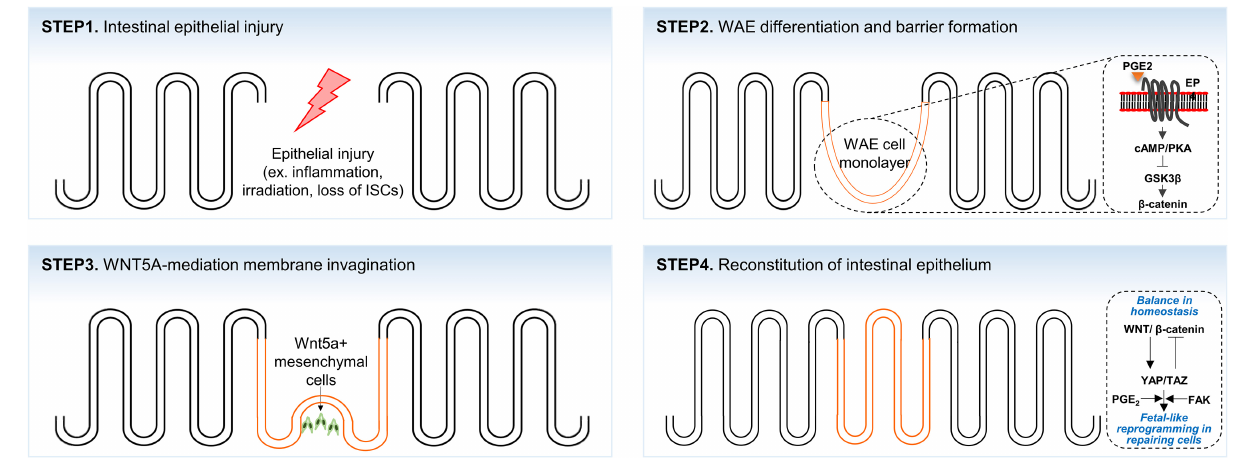
FIGURE 2 | A scheme of the crypt-villus morphogenesis during tissue regeneration. Intestinal epithelium lost by intestinal injuries (STEP1) is rapidly re-epithelialized by wound-associated cell (WAE) monolayer (orange color; STEP2). Morphological transformation of the WAE monolayer into crypt-villus structure is initiated by WNT5A + mesenchymal cells (STEP3) that subsequently develop to fully reconstitute the epithelium